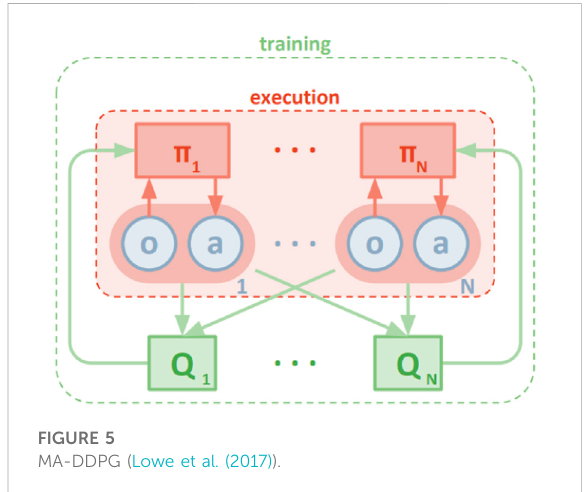
FIGURE 5 MA-DDPG (Lowe et al.